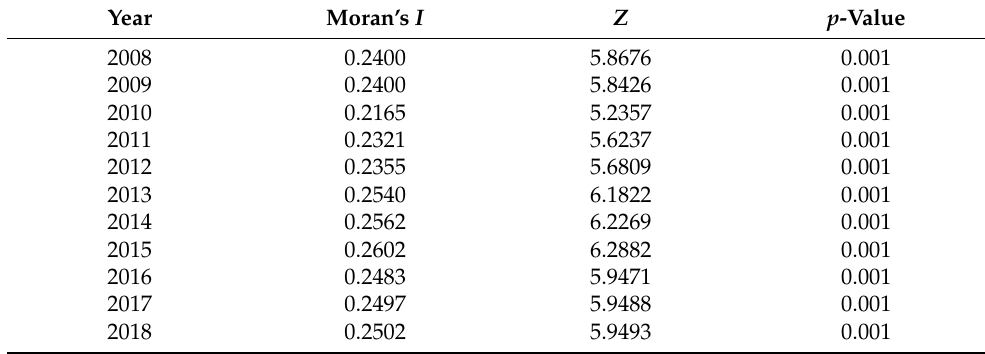
Table 4. The global spatial autocorrelation of UCEs in China between 2008 and